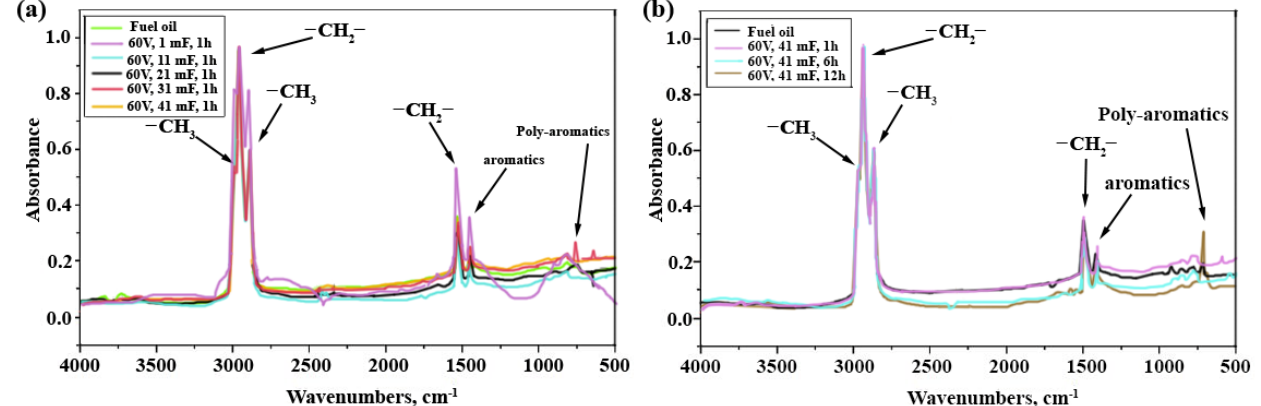
Figure 4. IR spectra of fuel oil and NTP pyrolysis product: ( a ) effect of capacitance of capacitor, ( b ) time of NTP pyrolysis process.